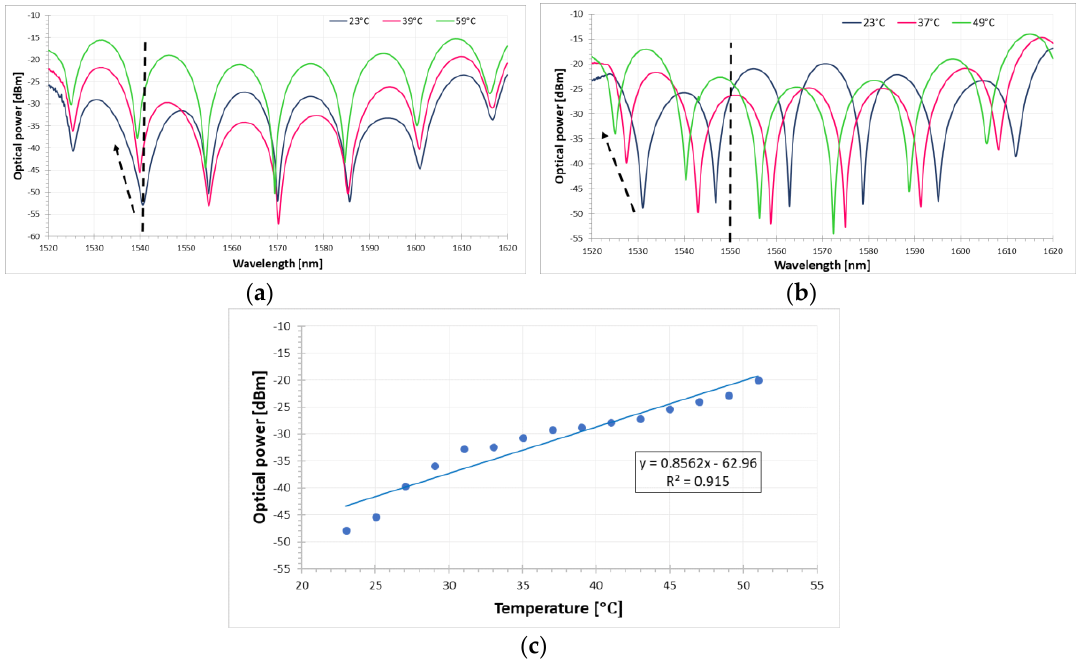
Figure 4. Transmission spectra of ( a ) DRLPG and ( b ) both PM and DRLPG for different temperatures in FLM-DRLPG structure. ( c ) Optical power of a single peak (λ = 1547 nm) versus external temperature with linear fit of the peak amplitude power changes.